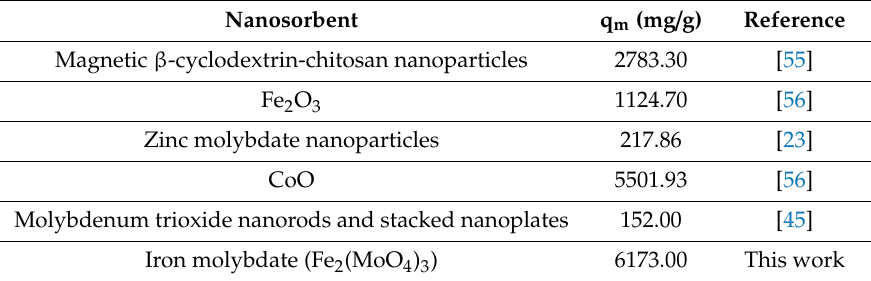
Table 6. The maximum removed amount (q m ) of MB dye reported in the literature.